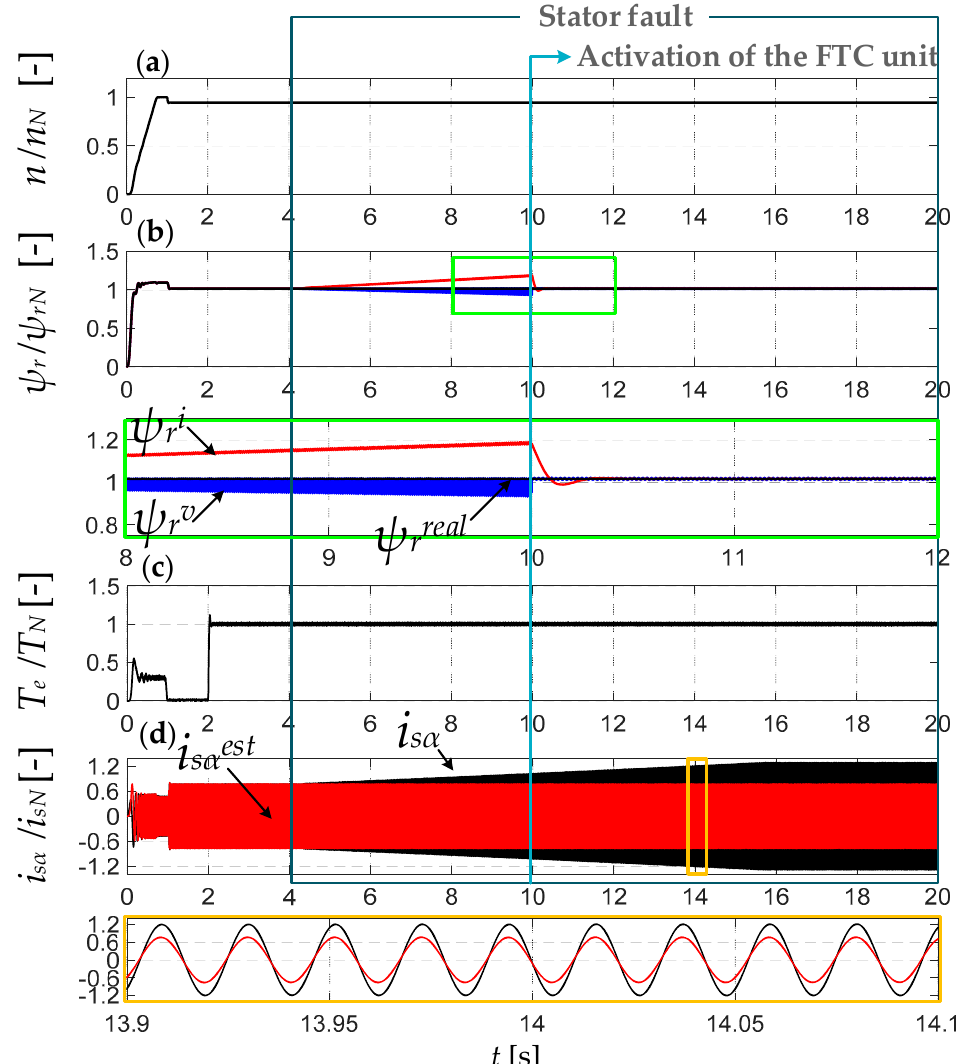
Figure 9. Operation of open-loop control scheme (v / f ) during ITSC with FTC unit: ( a ) rotor speed, ( b ) estimated and real rotor flux, ( c ) electromagnetic torque, ( d ) estimated and real stator current in phase A; (simulation results), ( n ref = n N , T l = T N ).